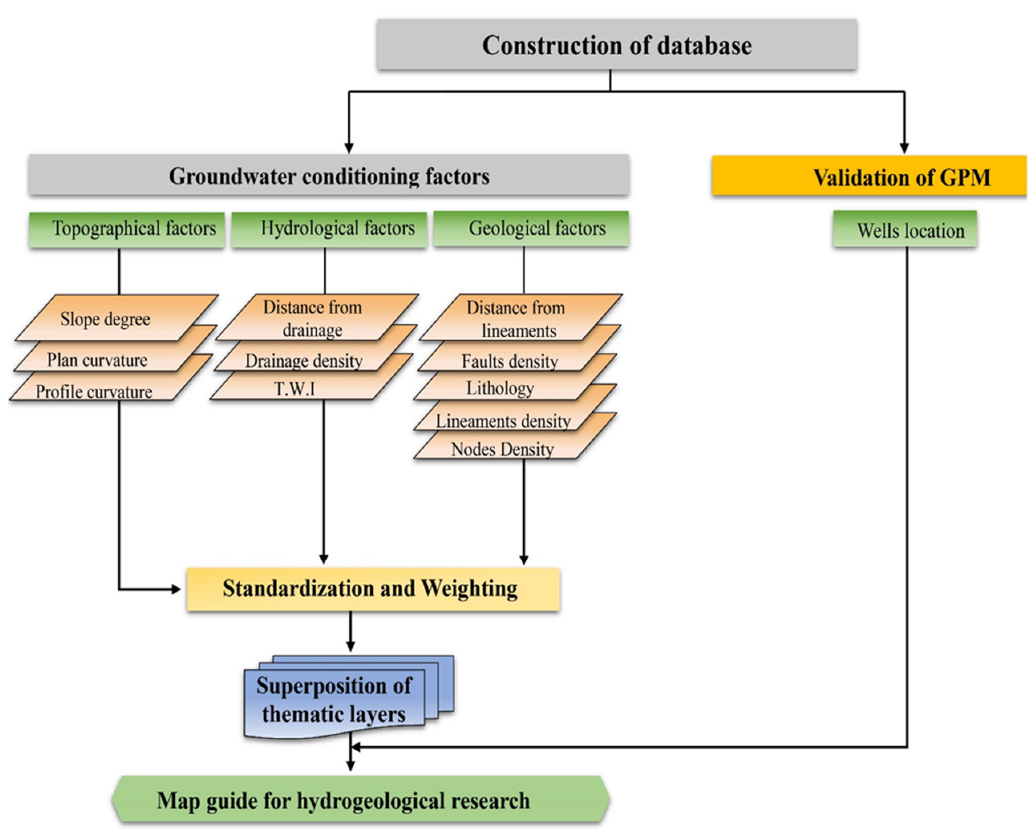
Figure 3. Flow chart of the methodology used in this study.